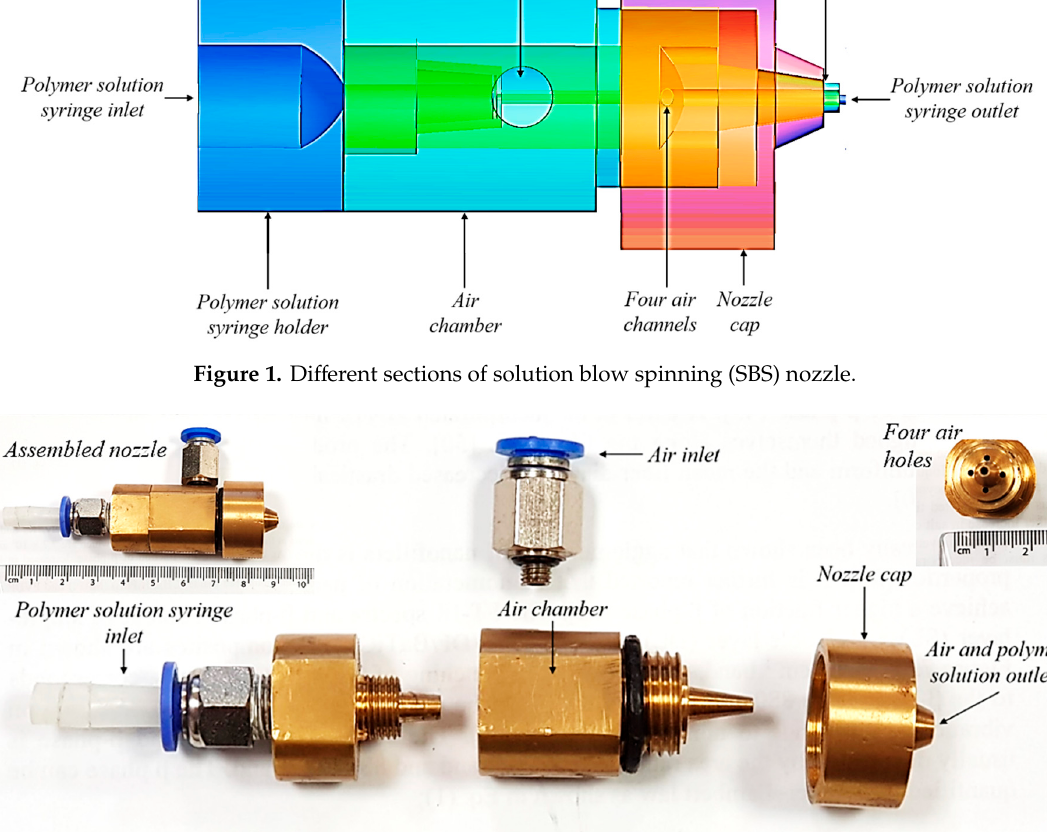
Figure 2. Various parts of the fabricated nozzle with four air holes through air chamber shown in the top right corner and assembled nozzle shown in the top left corner.